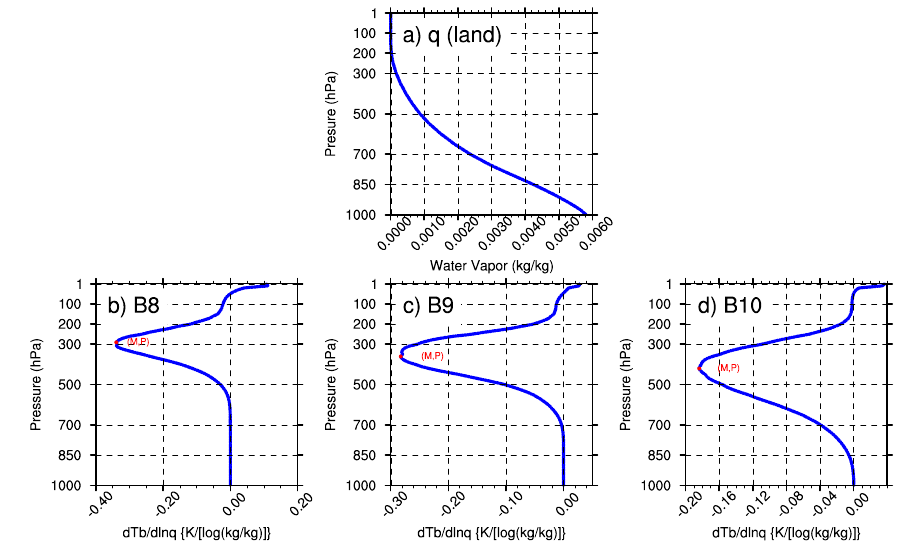
Figure 11. ( a ) The mean water vapor profile over the land area in the typical region of East Asia. ( b )–( d ) Corresponding Jacobian functions (M) and BWIL (P) of Band 8, Band 9 and Band 10, respectively.